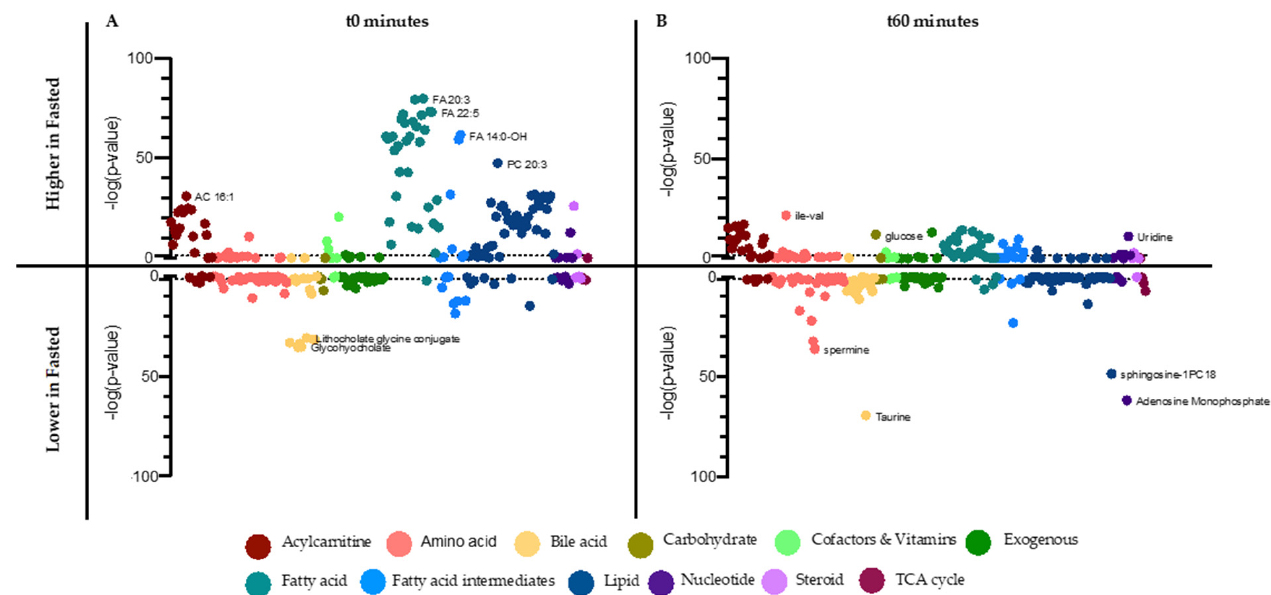
Figure 5. Differential metabolites between Fasted and Random-Fed in OVOB. Linear regression analyses identified metabolites associated with OVOB-Fasted and OVOB-Random-Fed (ßstate) at ( A ) t0 and ( B ) t60. On the top of the plots, metabolites are reported that are higher in OVOB-Fasted (ßstate < 0), with position indicated by − log10 ( p -value). On the bottom of the plots, metabolites are reported that are lower in OVOB-Fasted (ßstate > 0), with position indicated by − log10 ( p -value). Metabolites are listed in the same order in 5A and 5B. Colors indicate metabolite class. Horizontal lines (dotted) signify FDR = 0.1. Several distinguishing metabolite names are listed. Age and sex are included in the model.